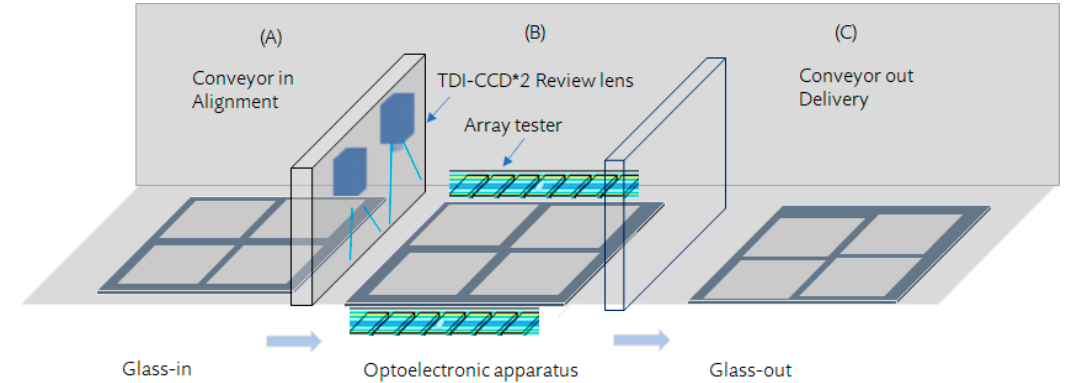
Figure 3. The architecture illustrates an array tester linked with the automatic optical inspection. ( A ) glass-in station; ( B ) optoelectronic apparatus station; ( C ) glass-out station. ( B ) optoelectronic apparatus station; ( C ) glass-out